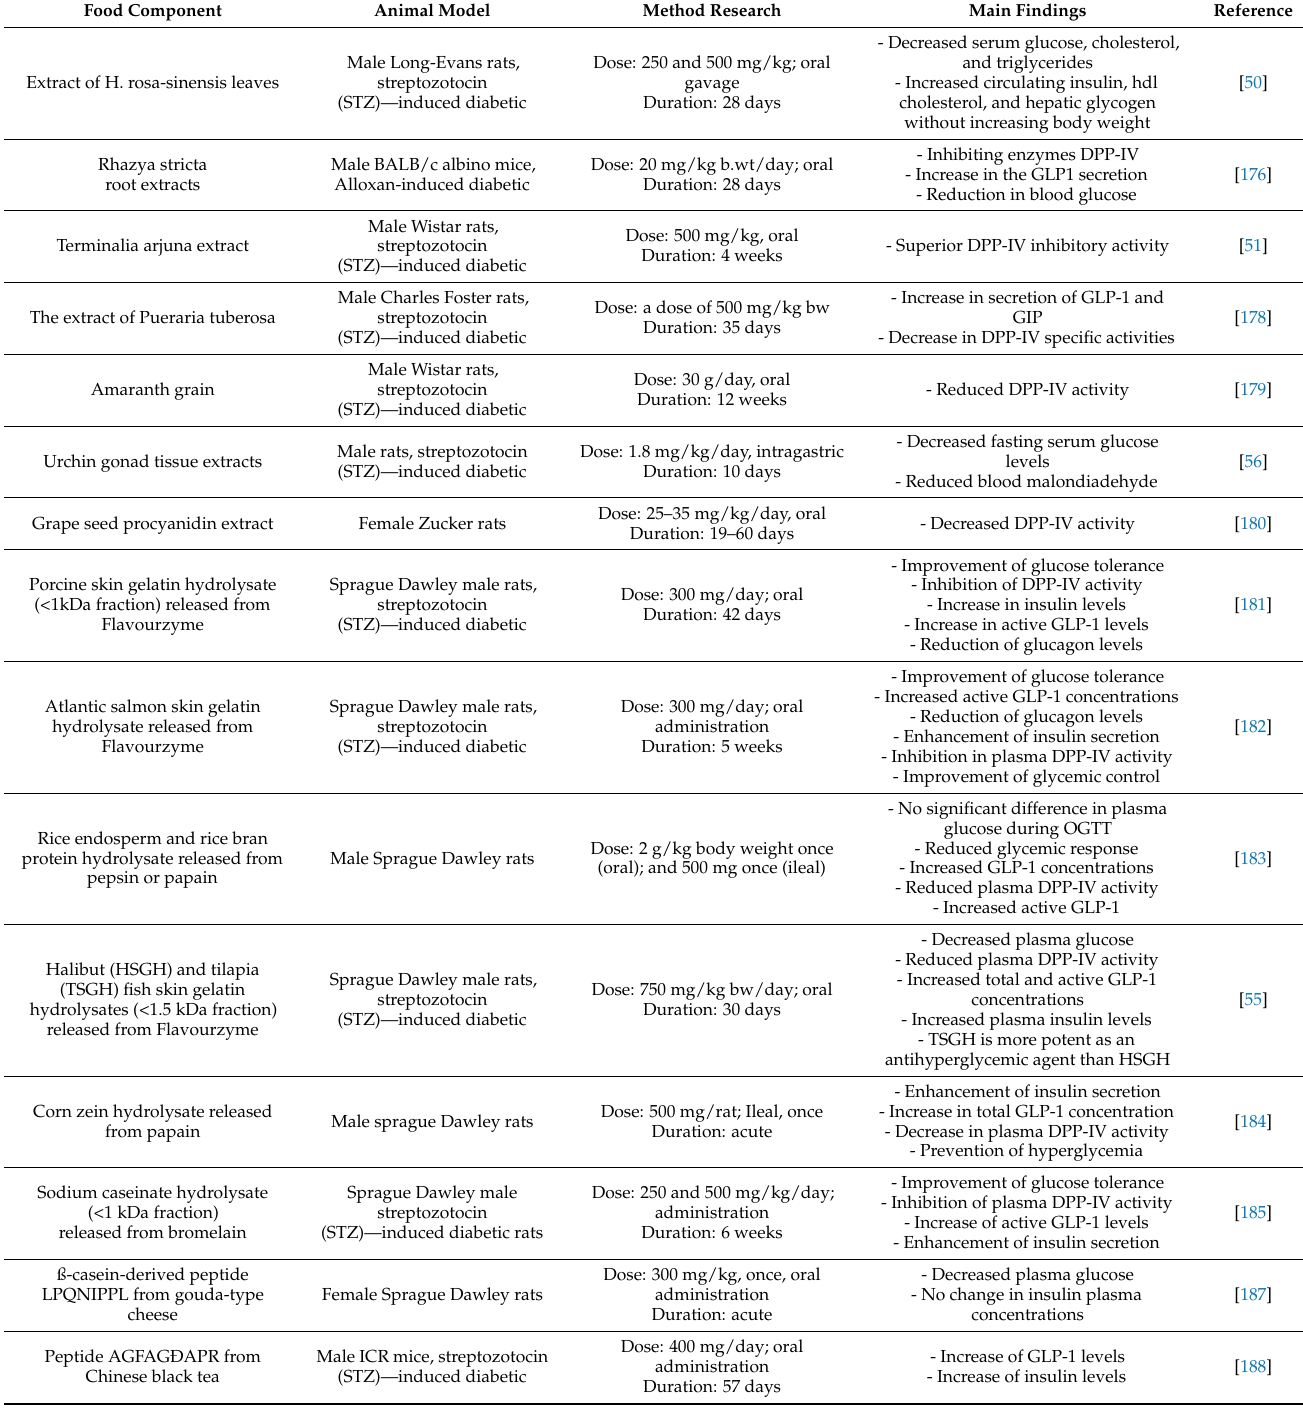
Table A5. In vivo studies on the glycemic regulatory effect of food-derived constituents with in vitro DPP-IV inhibitory